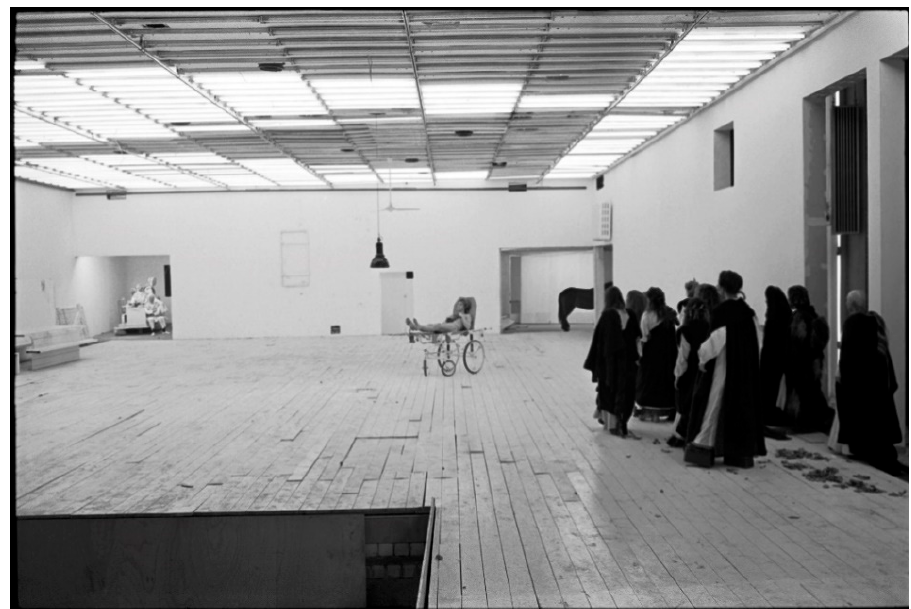
Figure 6. The Die Bakchen set, designed by Gilles Aillaud and Eduardo Arroyo, resembled a ‘white cube’ exhibition space. Deutsches Theatermuseum München, © Helga Kneidl.